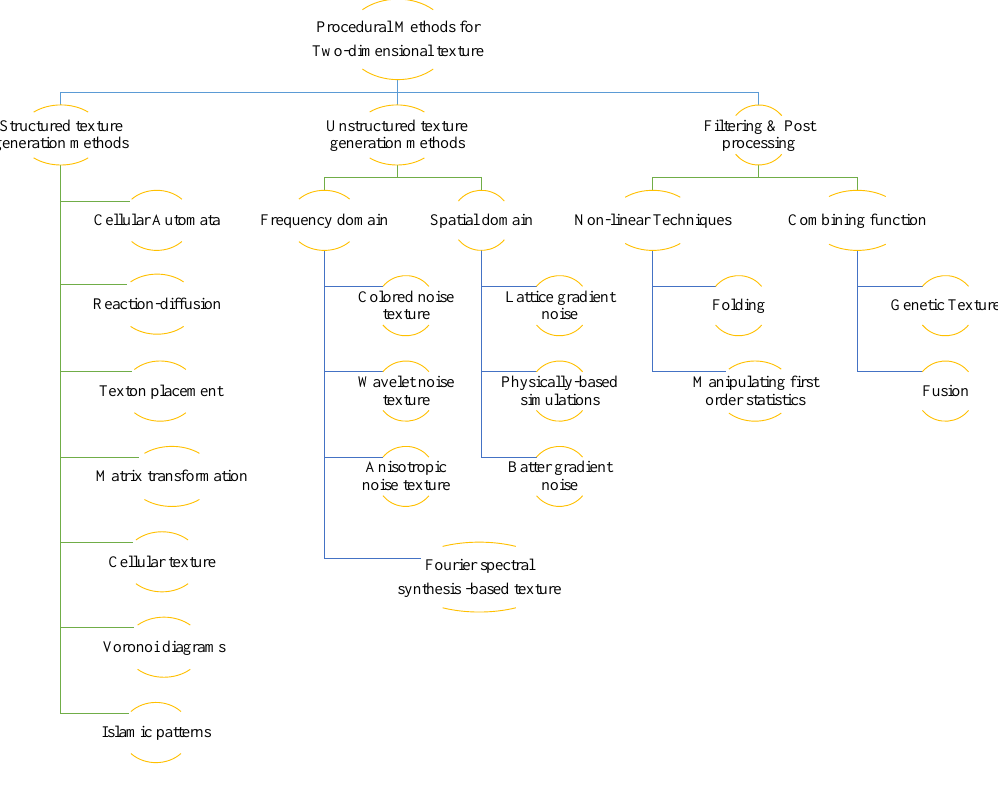
Figure 1. Procedural methods for two-dimensional